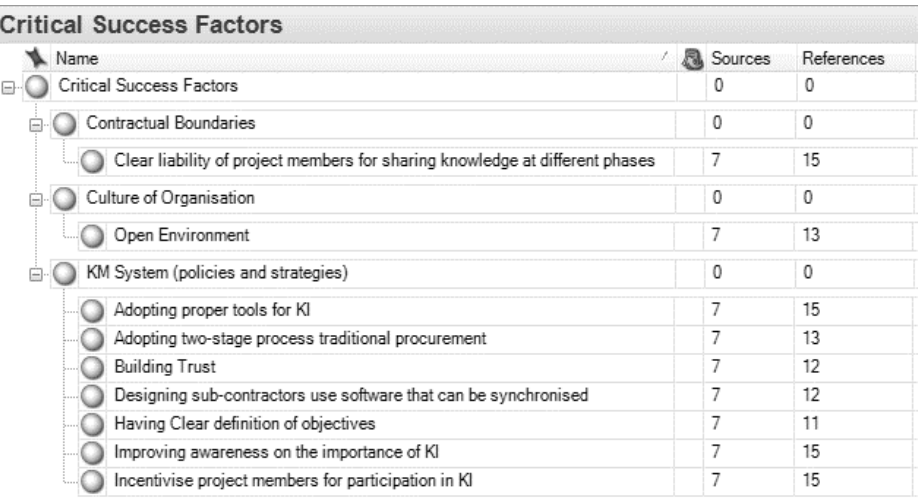
Figure 2. Screenshot showing nodes on CSFs of Knowledge